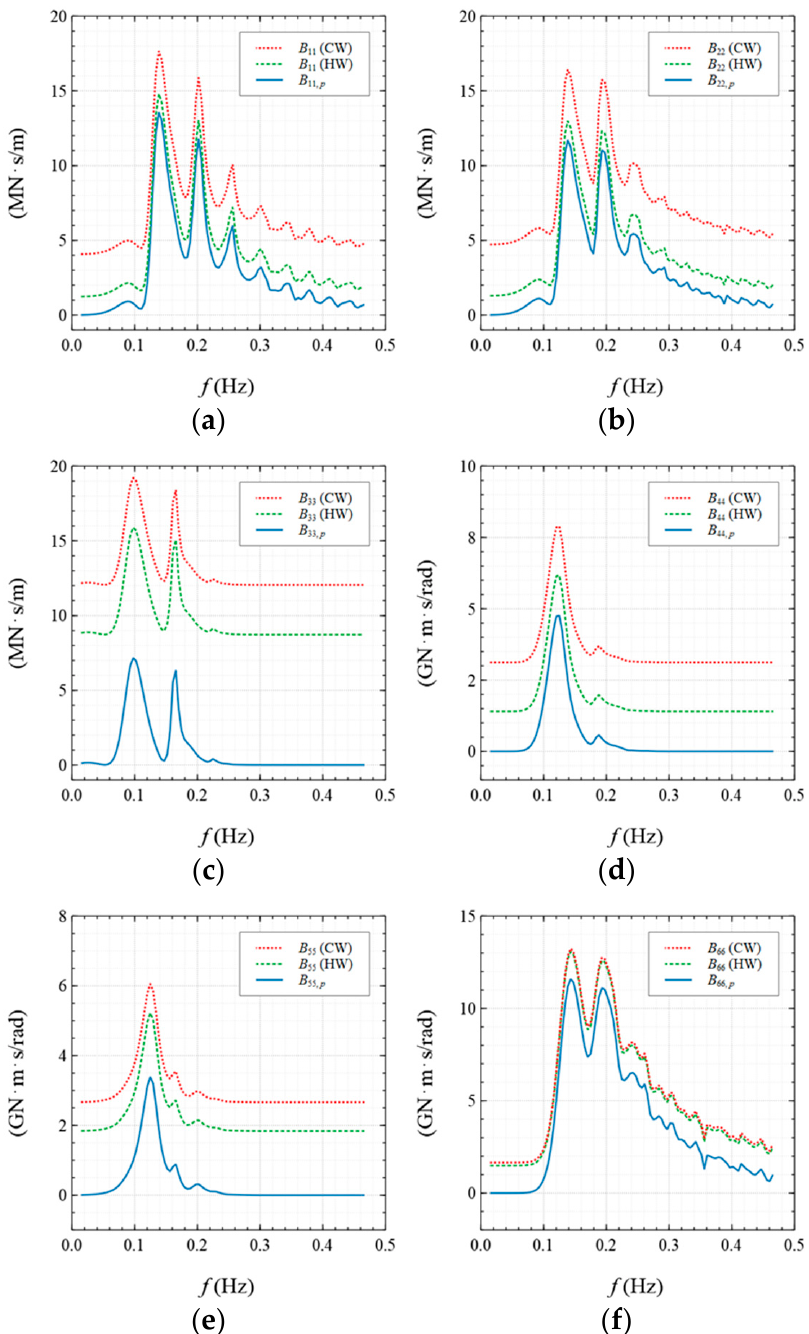
Figure 12. Comparison of damping in different motion directions: ( a ) surge; ( b ) sway; ( c ) heave; ( d ) roll; ( e ) pitch; ( f ) yaw.